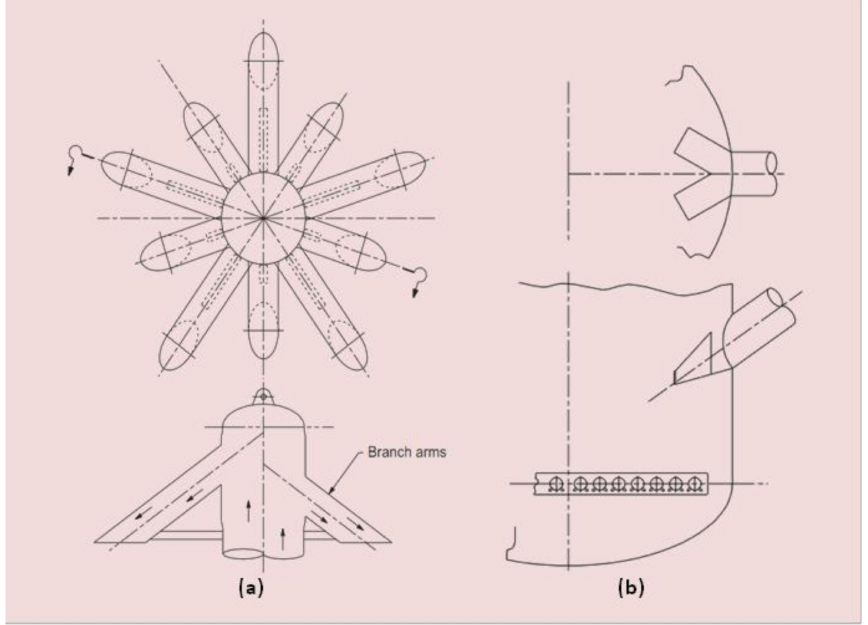
Figure 12. Design of spent catalyst distributor. ( a ) RMS bottom-center style; ( b ) hockey stick injection style. Adopted from Sadeghbeigi